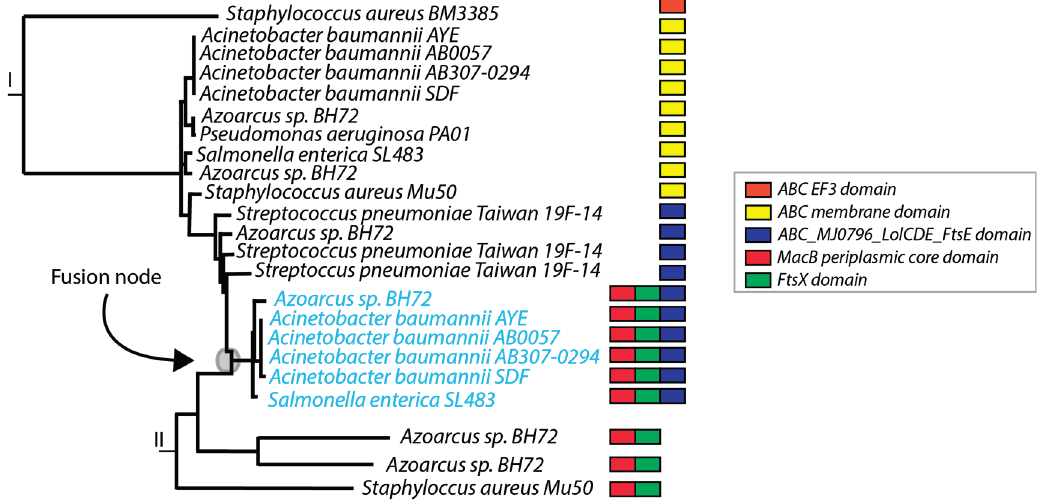
Figure 5. Two-rooted fusion graph. This two-rooted graph was constructed using the two phylogenetic trees from Figure 4. The trees were mid-point rooted and merged using Adobe Illustrator. The two roots are marked I and II. The grey dot, labelled “Fusion node” indicates the approximate location of the fusion event. The coloured squares display the domain architecture of the